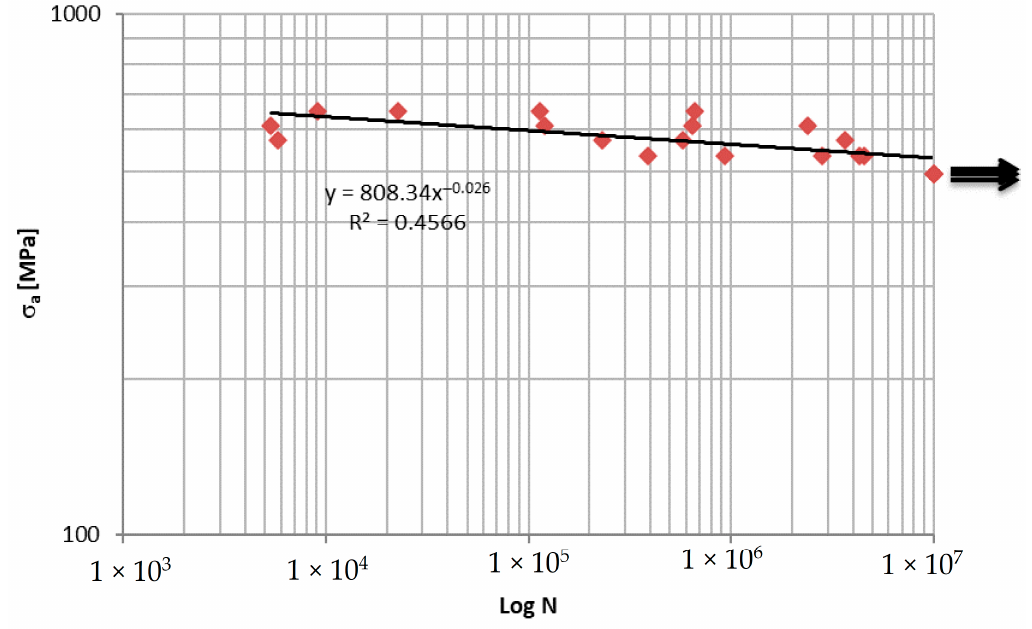
Figure 2. Wöhler curve of the unidirectional composite.